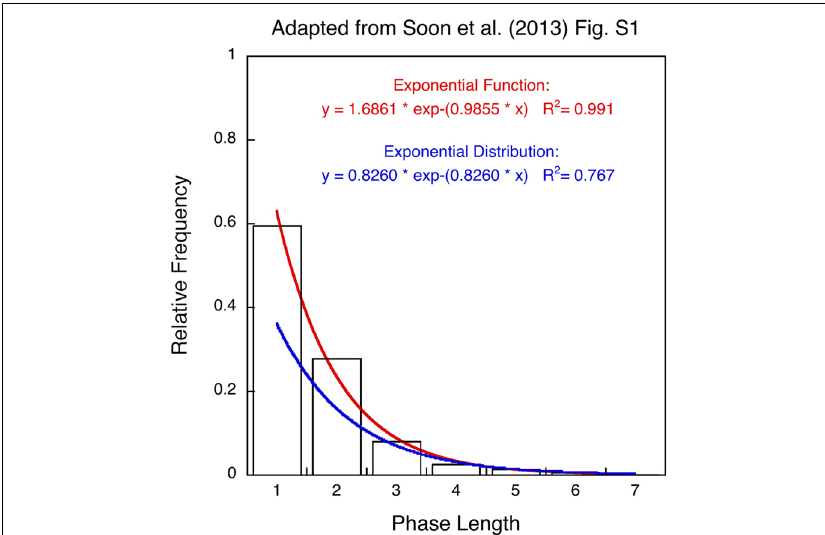
FIGURE 1 | Histogram for length of response sequences (phase length or runs) re-plotted as relative frequencies (adapted from Figure S1 in Soon et al., 2013). The data points are fitted by an exponential function with two parameters (red curve) and an exponential distribution with a single parameter (blue curve). The red curve provides an excellent fit ( R 2 = 0 . 99) whereas the blue curve underestimates phase length 1 and 2 ( R 2 = 0 . 77). See text for